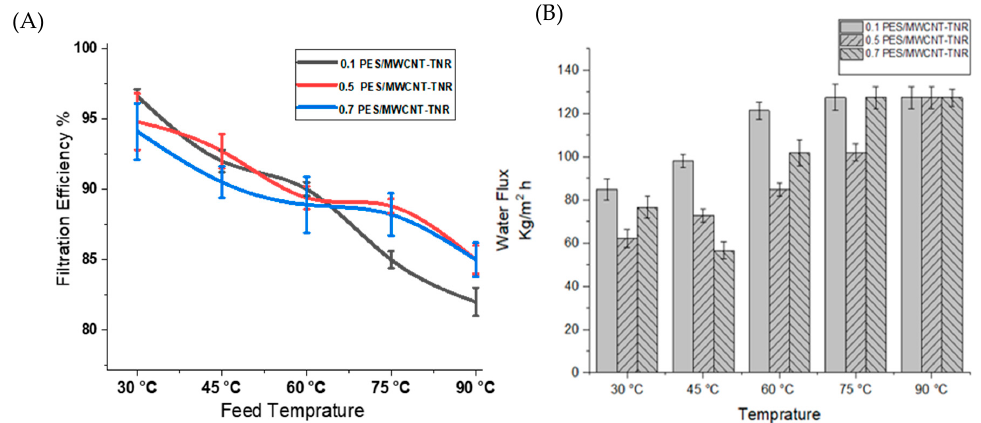
Figure 8. ( A ) Filtration efficiency and ( B ) water flux of the synthesized membranes versus feed sample temperature.